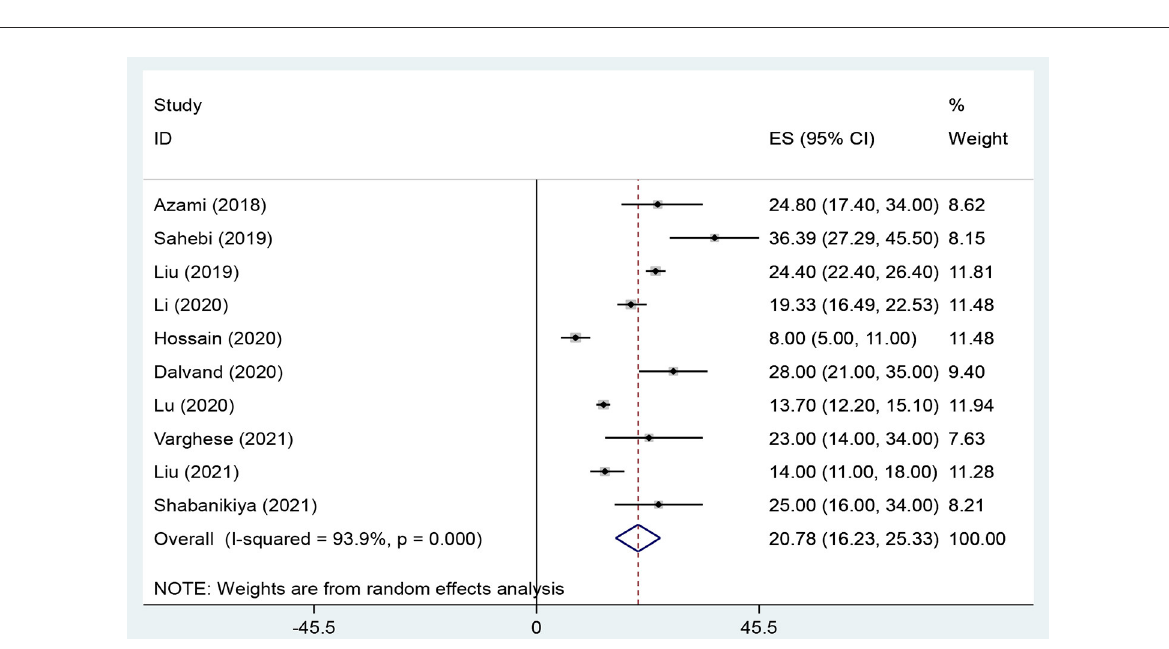
FIGURE3 The Forest plot of overall and individual prevalence of physical violence with 95% confidence